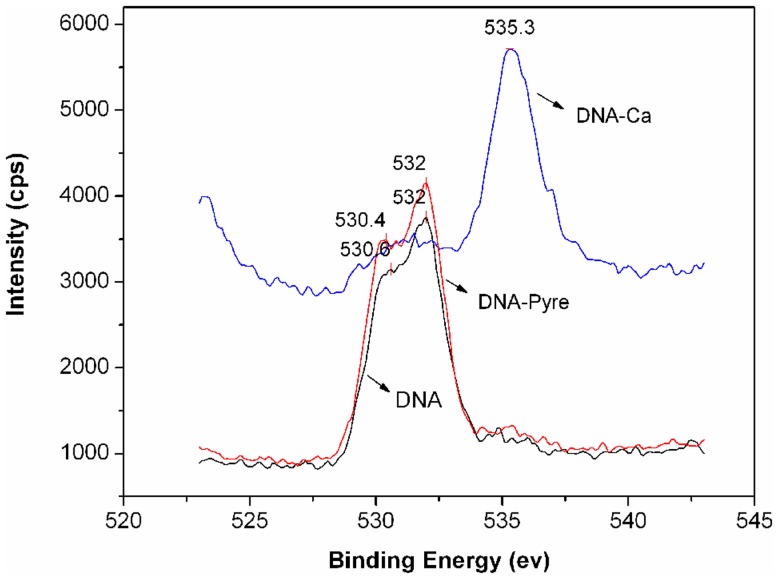
XPS analysis of oxygen in DNA, DNA–pyrene, and DNA–Ca.